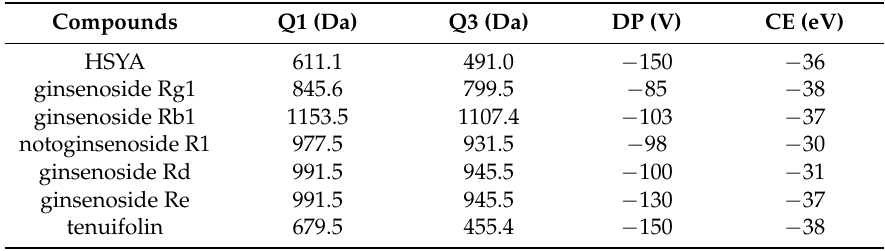
Table 1. The parent/fragment ion pairs and MS parameters for the six compounds in CNS and